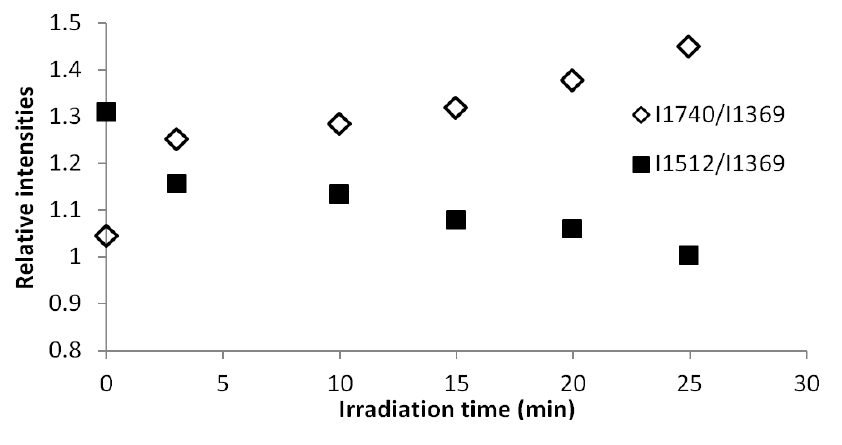
Figure 2. Relative intensity change of 1740 cm −1 and 1512 cm −1 peaks as a ratio of 1369 cm −1 peak after UV treatment for different